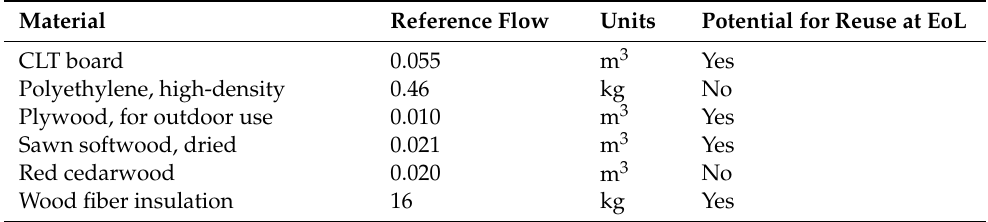
Table 2. Bill of materials for one functional unit (FU = 1 m 2 ) of CLT-based wall assembly. Reference flow = amount of material required per FU.